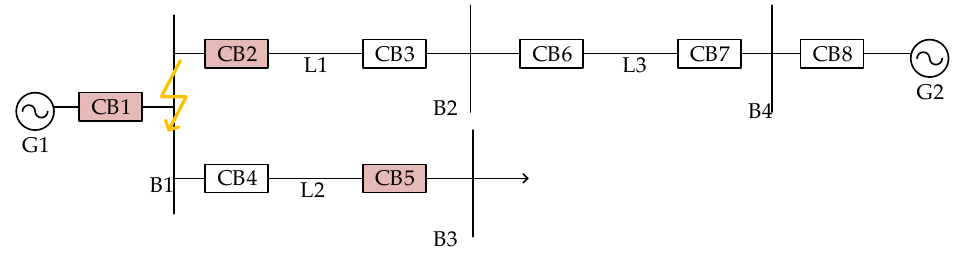
Figure 3. Simple power grid fault. Table 2. Instance representation of B1, L1, L2 and BP_B1, RBP_L2_B3.